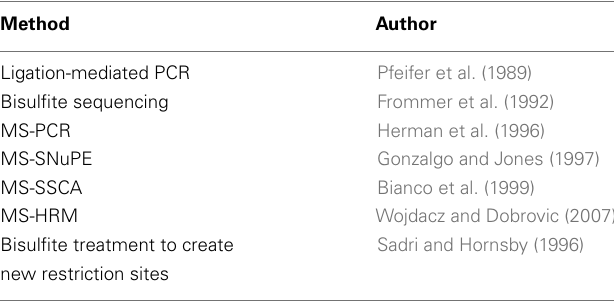
Table 3 | Summary of methods using sodium bisulfite